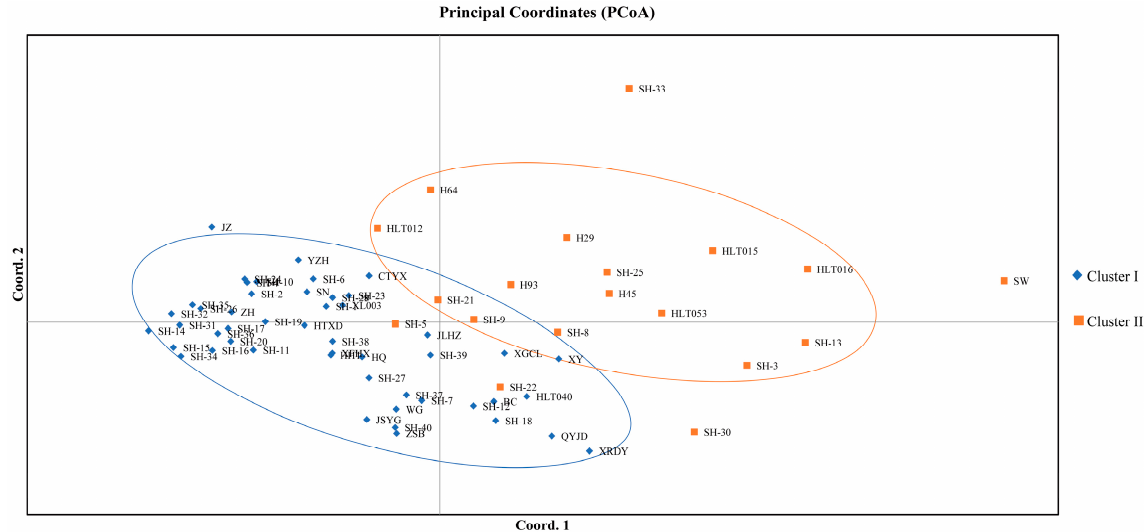
Figure 7. Phylogenetic analysis of 69 wintersweet samples based on genetic distance. ( A ) Results of the Mantel test. ( B ) Genetic clustering diagram. Blue, purple, yellow, green and red dots represented wintersweet samples from Shanghai, Sichuan, Nanjing, Kunming and Wuhan, respectively.